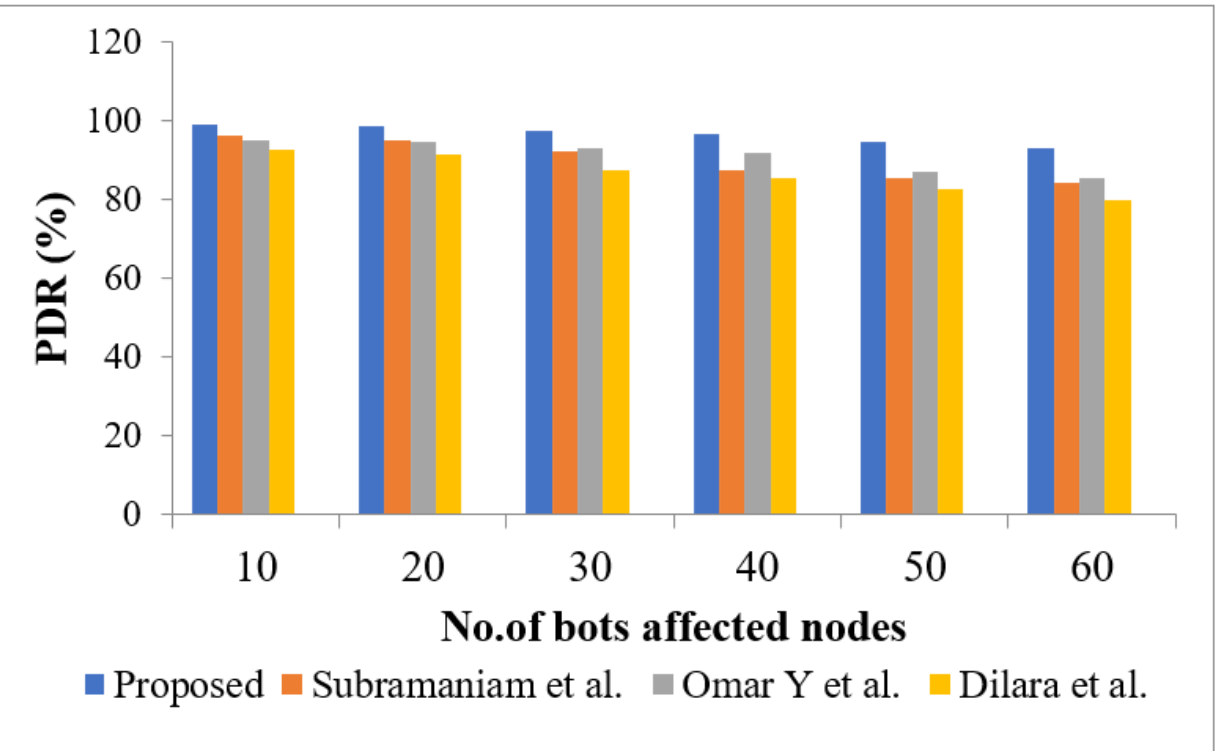
Figure 7. Graphical comparisons of PDR.